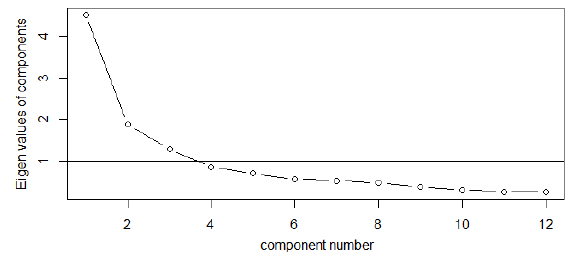
Figure 3. Scree plot of eigenvalues for identifying the optimal number of factors.